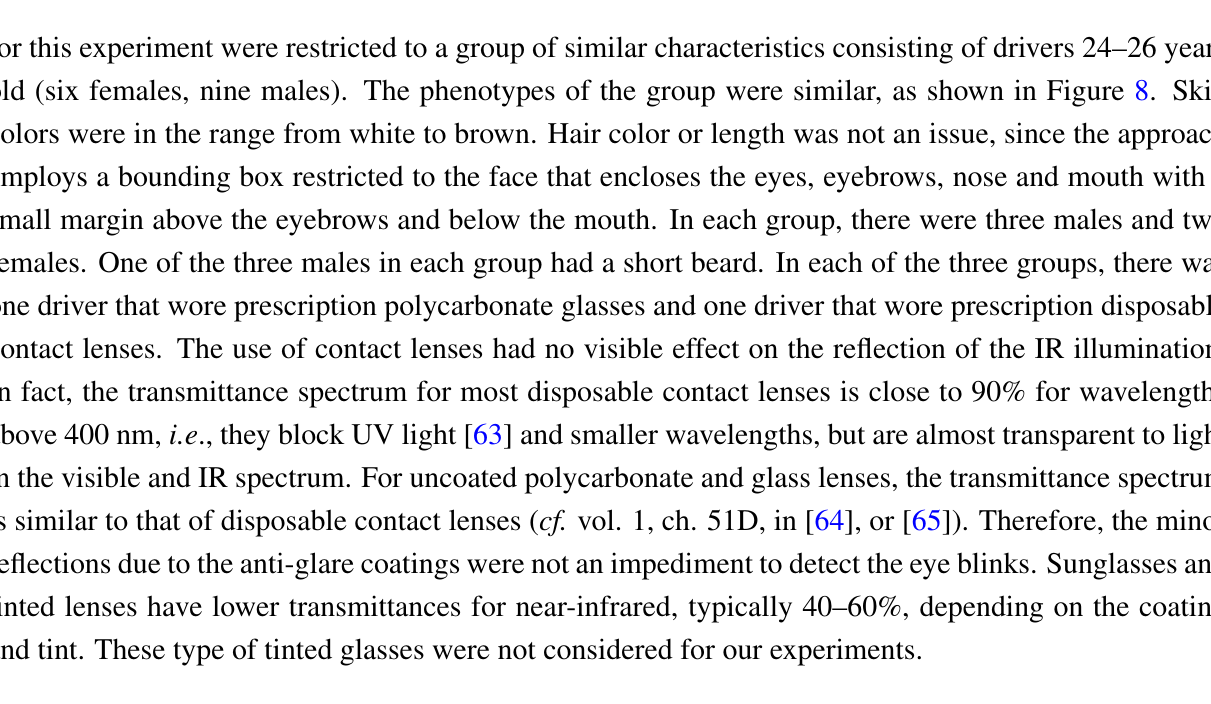
Figure 8. Five of the fifteen participants in the driving experiments under different levels of sleep